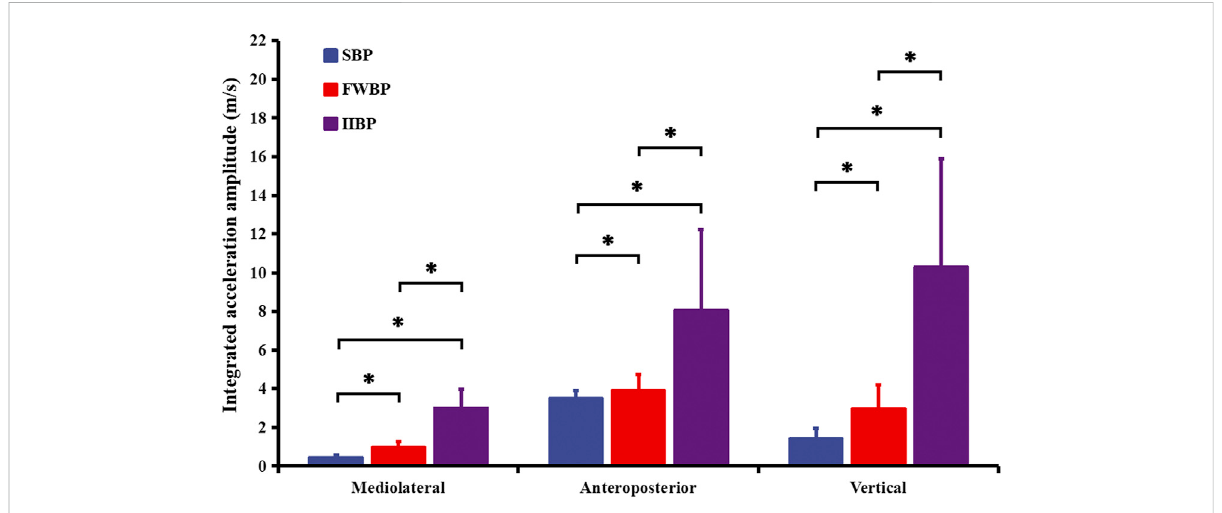
FIGURE 3 Integrated acceleration amplitude in mediolateral, anteroposterior, and vertical directions for three different bench press conditions. Results were expressed as mean ± SD. Signi fi cant differences are indicated by asterisks ( p < 0.05).